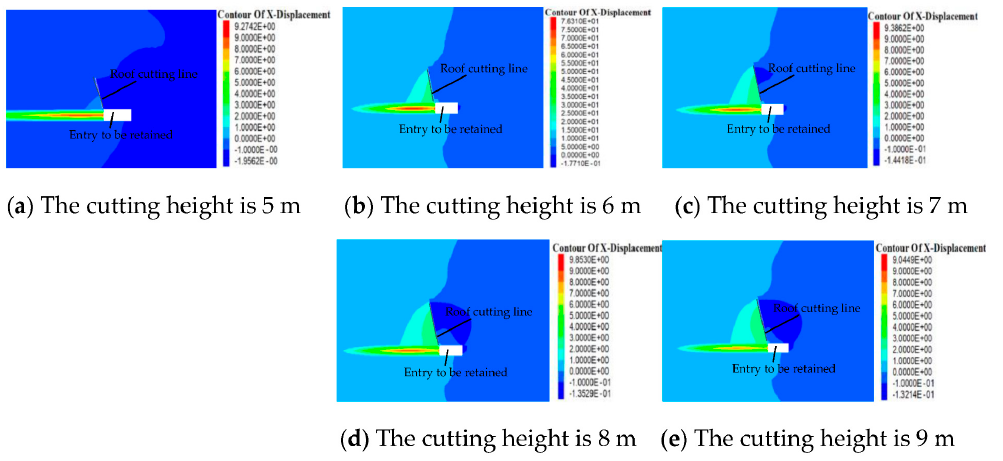
Figure 9. Horizontal displacement of roadway surrounding rock under different cutting heights.